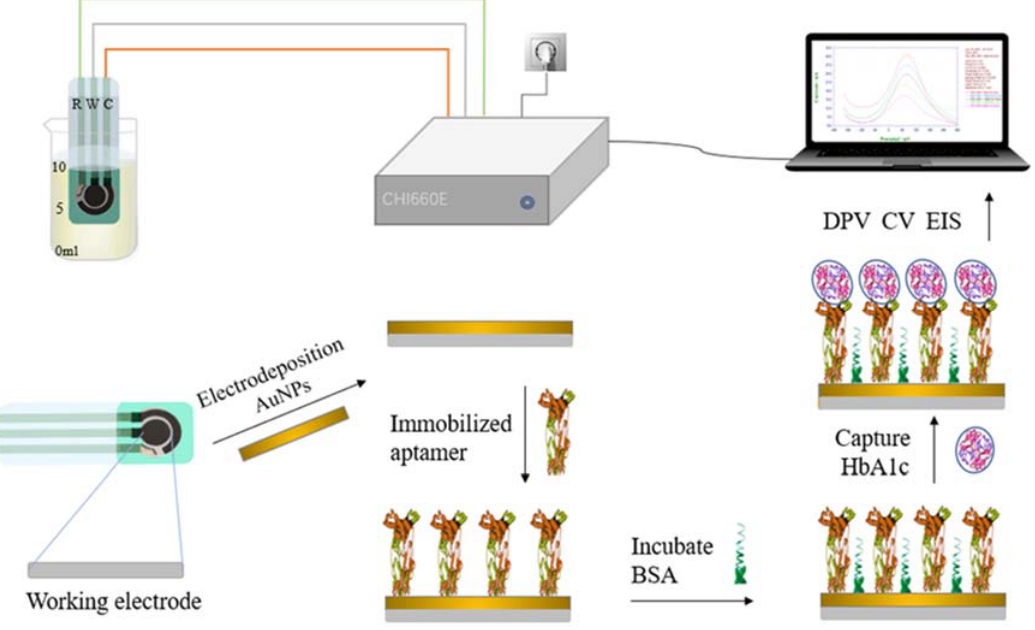
Figure 2. Schematic diagram of the proposed electrochemical HbA1c immunosensor.